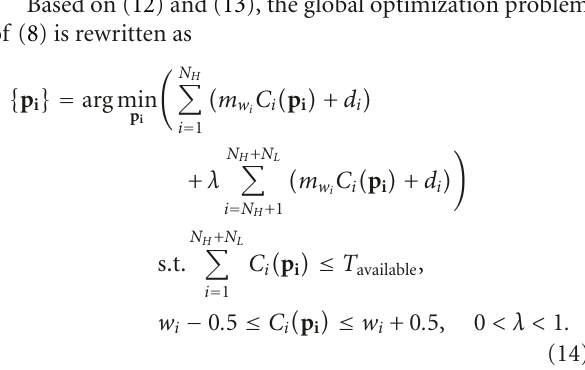
Figure 15: The PSNR values of the Bus sequence when the target encoding time for each frame is 40